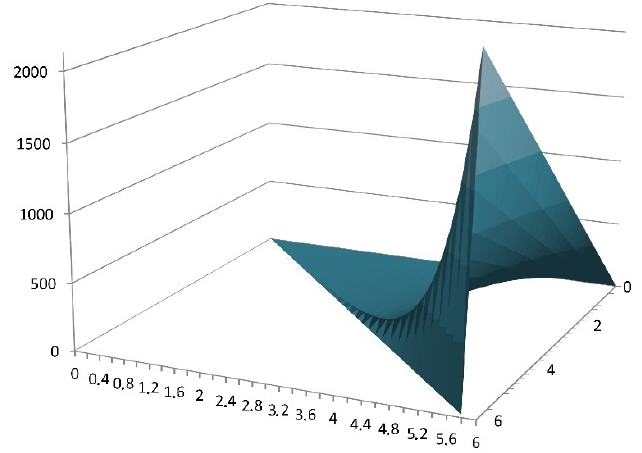
Figure 8. The surface generated by the function f ( τ (cid:48) , τ (cid:48)(cid:48) ) = e τ (cid:48) τ (cid:48)(cid:48)